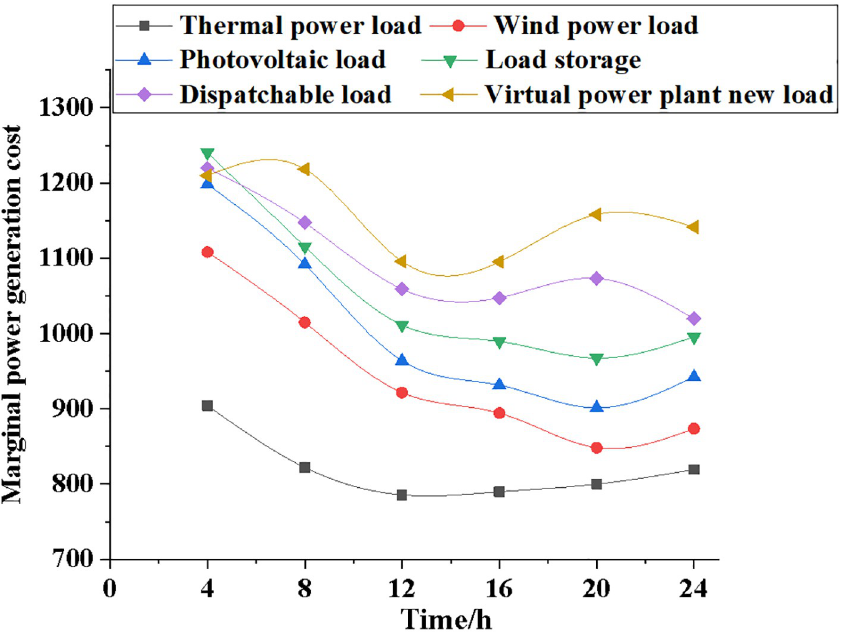
Fig 11. Comparison of marginal generation costs for different types of electrical